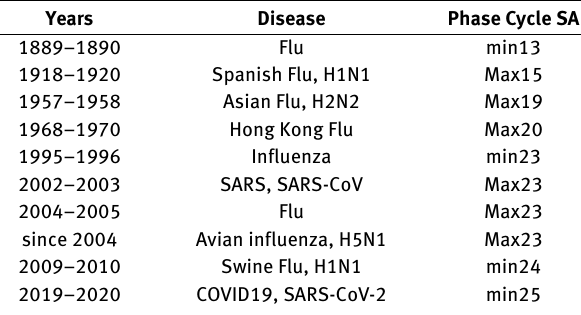
Moreover, the maximum values of mortality are ob- served in fairly prosperous countries with a high level of medicine. This paradoxical variability of the deaths per 1 million people (more than 4-8 times in different countries) requires an explanation.